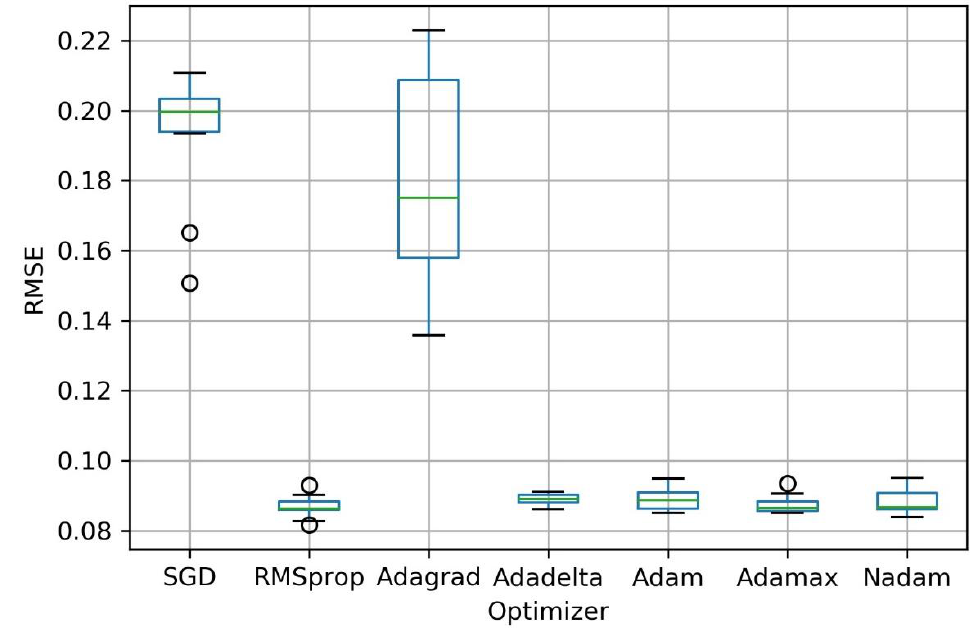
Figure 5. Box-and-whisker plot for optimization algorithm selection.